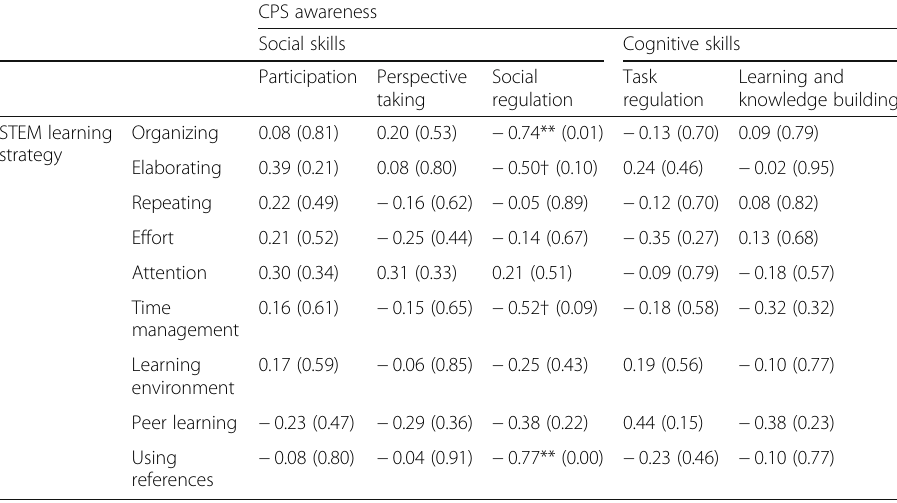
Table 6 Spearman ’ s rank correlation coefficients between CPS awareness and STEM learning